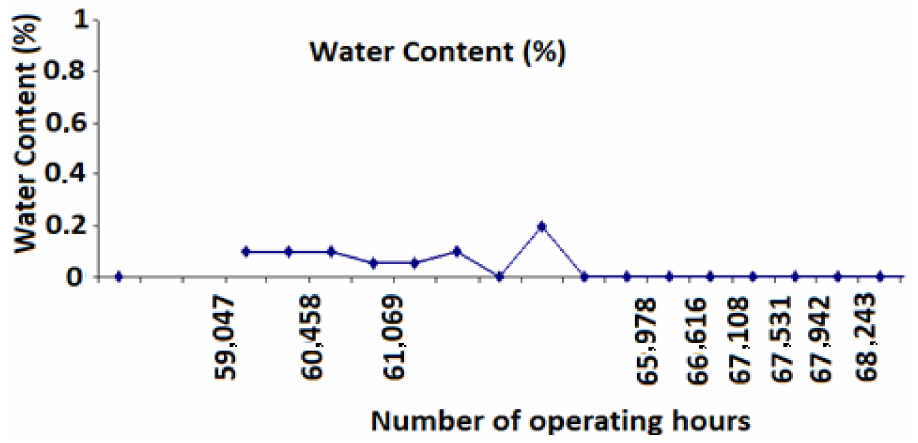
Figure 6. Water content and lubricating